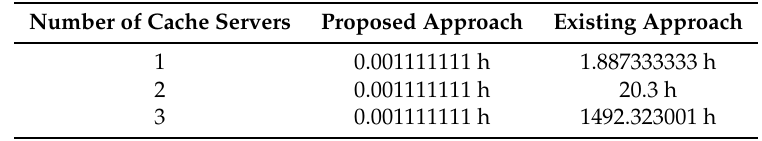
Table 2. The comparison of computation time in hours.